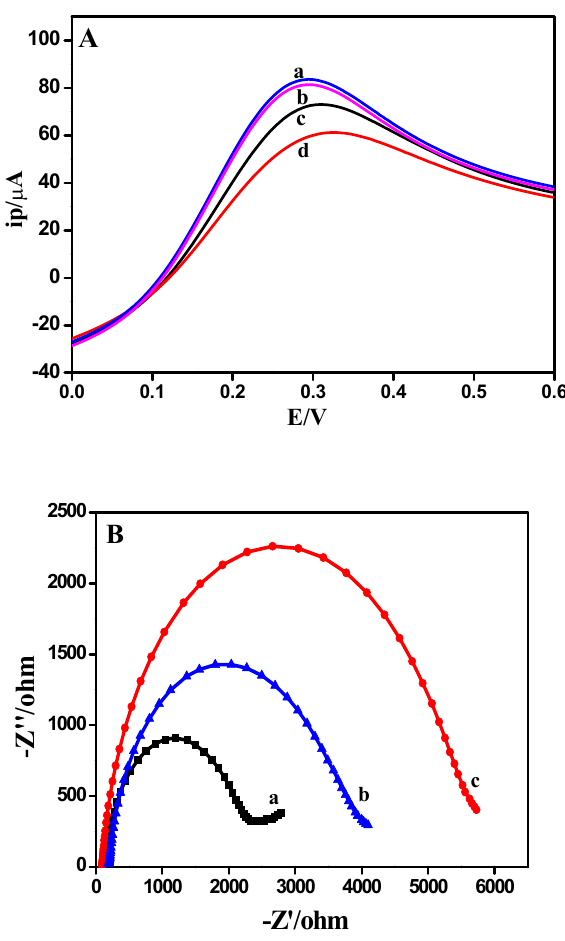
Figure 4. ( A ) Linear sweep voltammetrics (LSVs) of (a) chitosan-Zn/GCE, (b) actin/chitosan-Zn/GCE, (c) anti-actin/chitosan-Zn/GCE and (d) actin/anti-actin/chitosan-Zn/GCE in 0.1 M PBS (pH = 7.0). ( B ) Electrochemical impedance spectra (EISes) of (a) chitosan-Zn/GCE, (b) anti-actin/chitosan-Zn/GCE and (c) actin/anti-actin/chitosan-Zn/GCE in 0.1 M PBS (pH = 7.0) containing 5 mM [Fe(CN) 6 ] 3 − /4 − (1:1) solution and 0.1 M KCl. Scan rate: 100 mV/s.